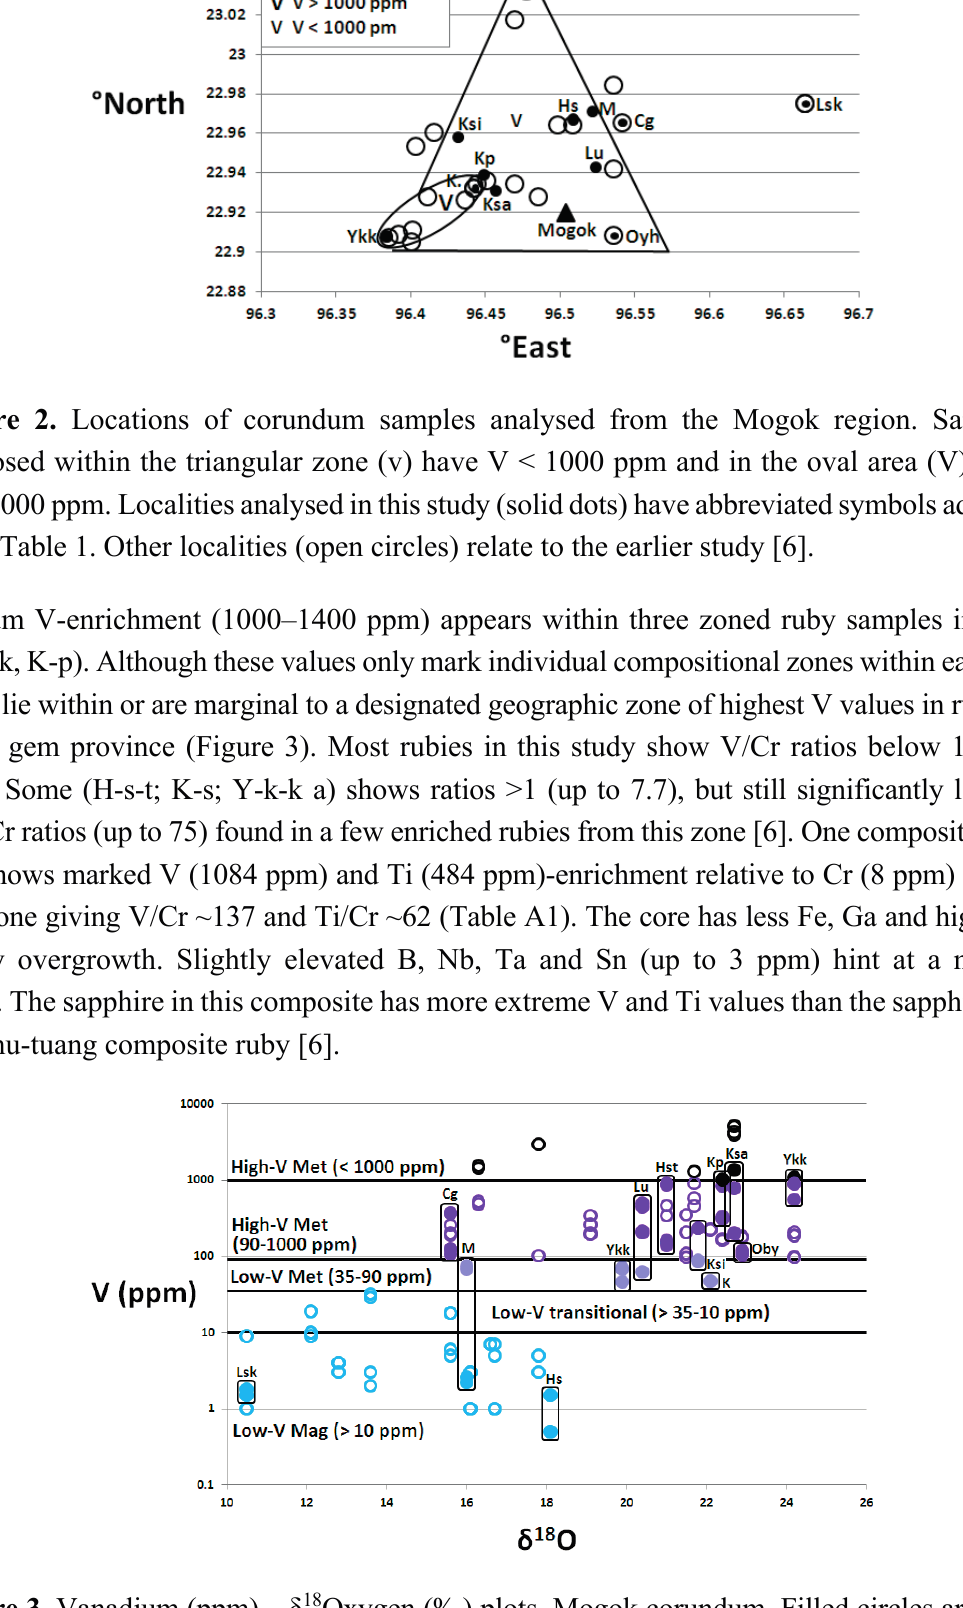
Figure 3. Vanadium (ppm)— δ 18 Oxygen (‰) plots, Mogok corundum. Filled circles are new results (locality symbols from Table 1); open circles represent earlier results [6]. Boxes enclose results on samples from the same site. Met = metamorphic, Mag =